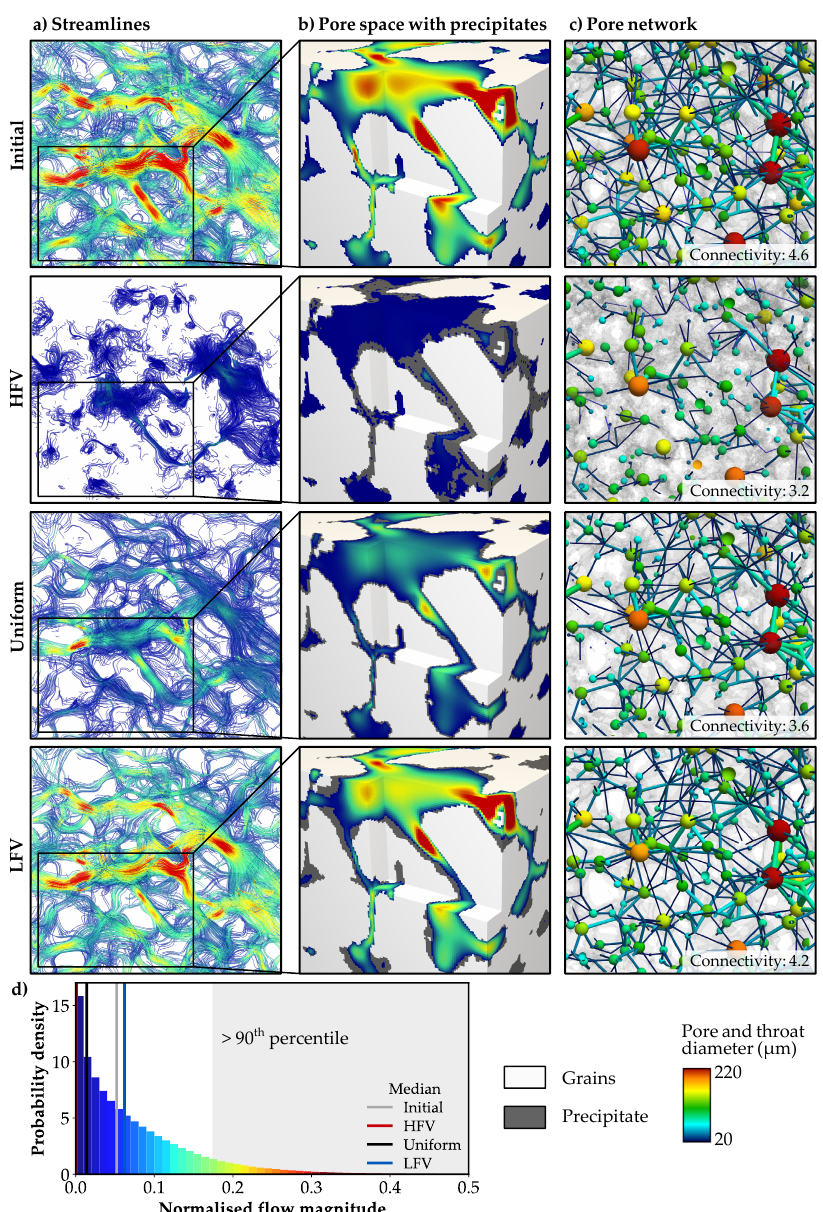
Figure 6. Flow regime of the initial microstructure compared to the three spatial alteration patterns. ( a ) Streamlines for flow in x-direction coloured by the velocity magnitude. ( b ) Changes in velocity magnitude relate to the location of precipitation (grey) and the resulting alteration in the ( c ) connectivity of the pore network. ( d ) Histogram of the normalised flow velocity magnitude for the initial microstructure including the changes of the median flow magnitude for the three spatial alteration